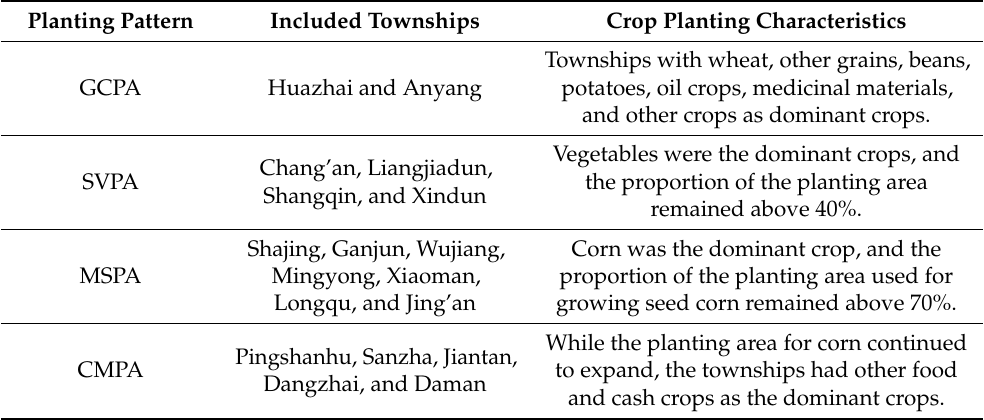
Table 5. Average pressure on resources and the environment under different crop planting patterns in Ganzhou district